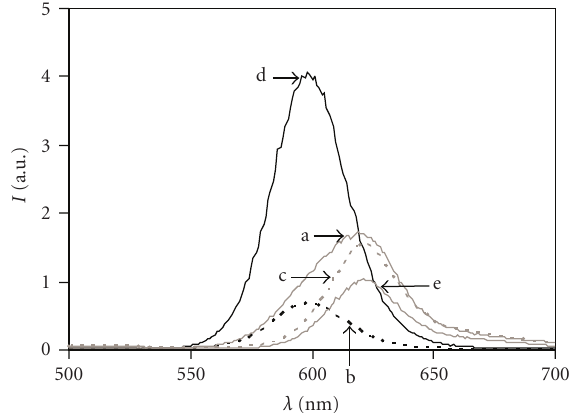
Figure 7: Emission spectra of a mixture of CdSe-ZnS core-shell QDs (0.1 μ M), His 6 -PDK1( Δ PH) (10 μ M), BODIPY-ATP (10 μ M) and ATP (301 μ M) (a) CdSe-ZnS core-shell QDs (0.1 μ M) (d) and BODIPY-ATP (10 μ M) (e) in borate bu ff er (pH = 7.4, T = 20 ◦ C, λ EX = 442 nm). Deconvolution (b and c) of trace a.